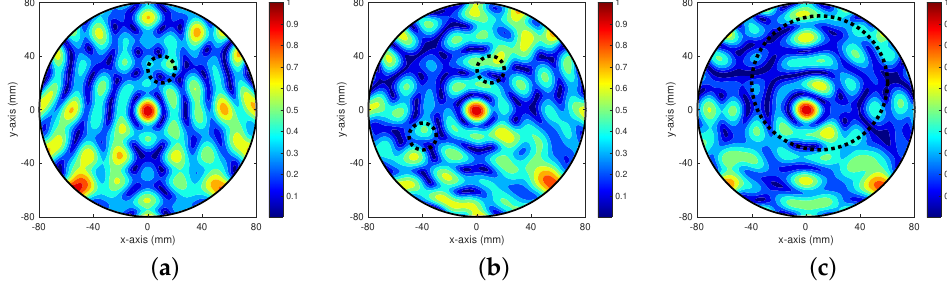
Figure 6. (Example 4) Maps of F BS ( r ,0 ) . Black-colored dashed line describes the boundaries of objec- tives. ( a ) Small objective (Example 1), ( b ) Small objectives (Example 2), ( c ) Large objective (Example